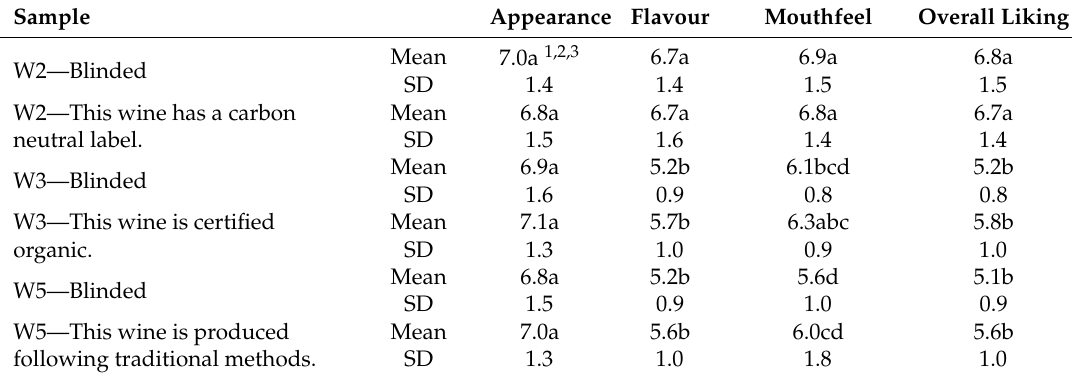
Table 4. Consumer mean liking scores and standard deviations (SD) for appearance, flavour, mouthfeel, and overall liking for the sparkling wine evaluated blinded and informed about the production